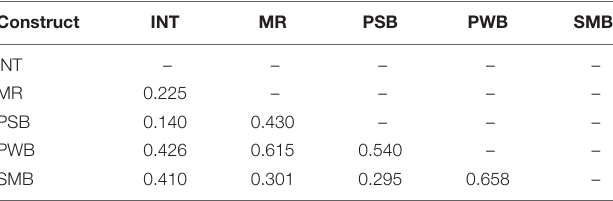
TABLE 3 | Discriminant validity